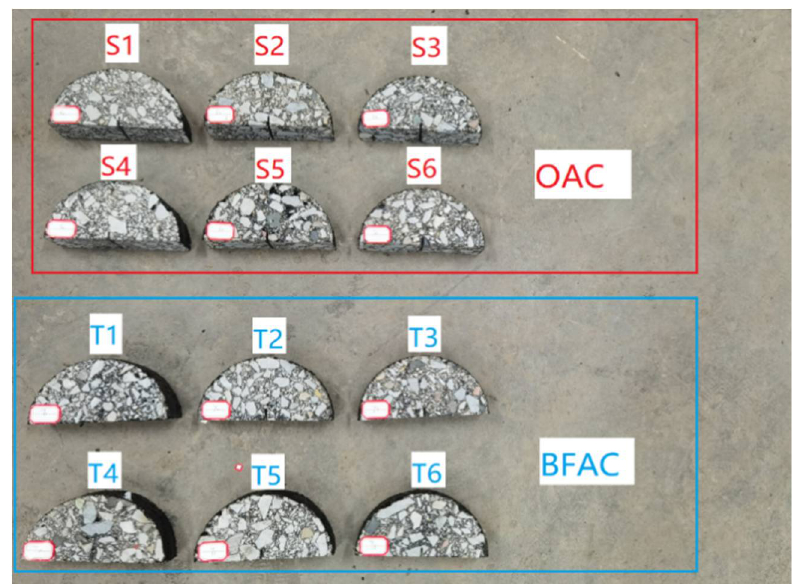
Figure 4. Formed specimens.